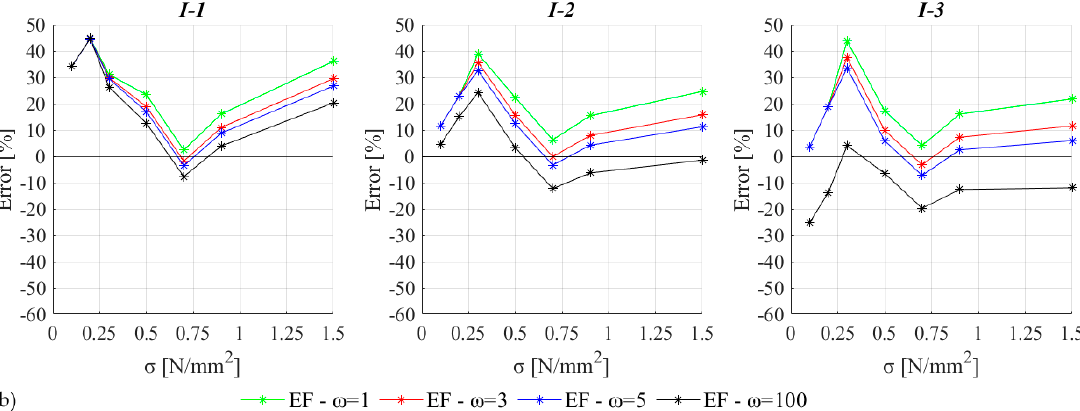
Figure 16. Percentage error of the estimate of the base shear provided by the EF model computed with respect the maximum base shear ( a ) or the equivalent yield base shear ( b ) of the FE model.